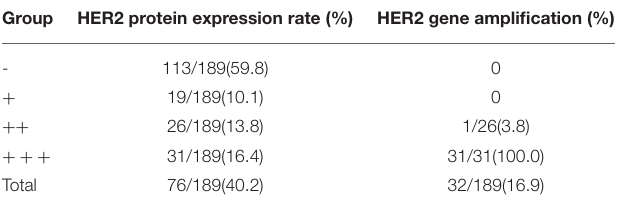
TABLE 4 | Comparison of HER2 gene protein expression and HER2 gene amplification in tissues of 189 cases of gastric adenocarcinoma with mucinous differentiation.